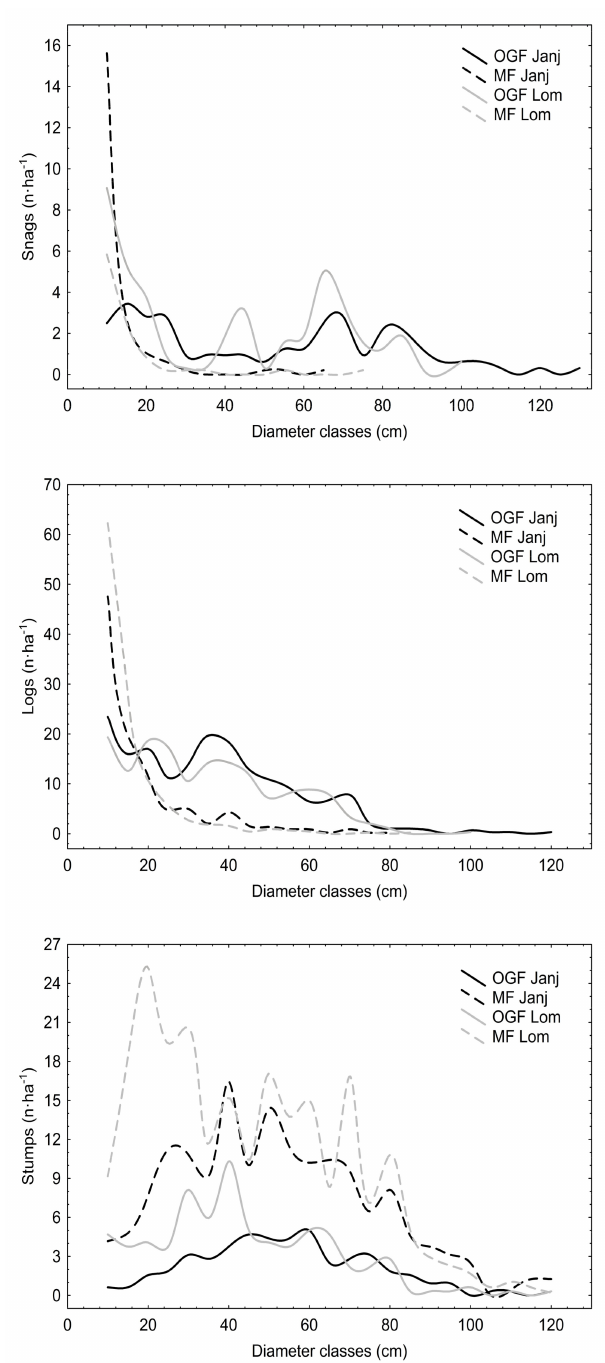
Figure 3. Diameter distribution of snags, logs, and stumps in old-growth forests (OGFs) and managed forests (MFs) in Janj and